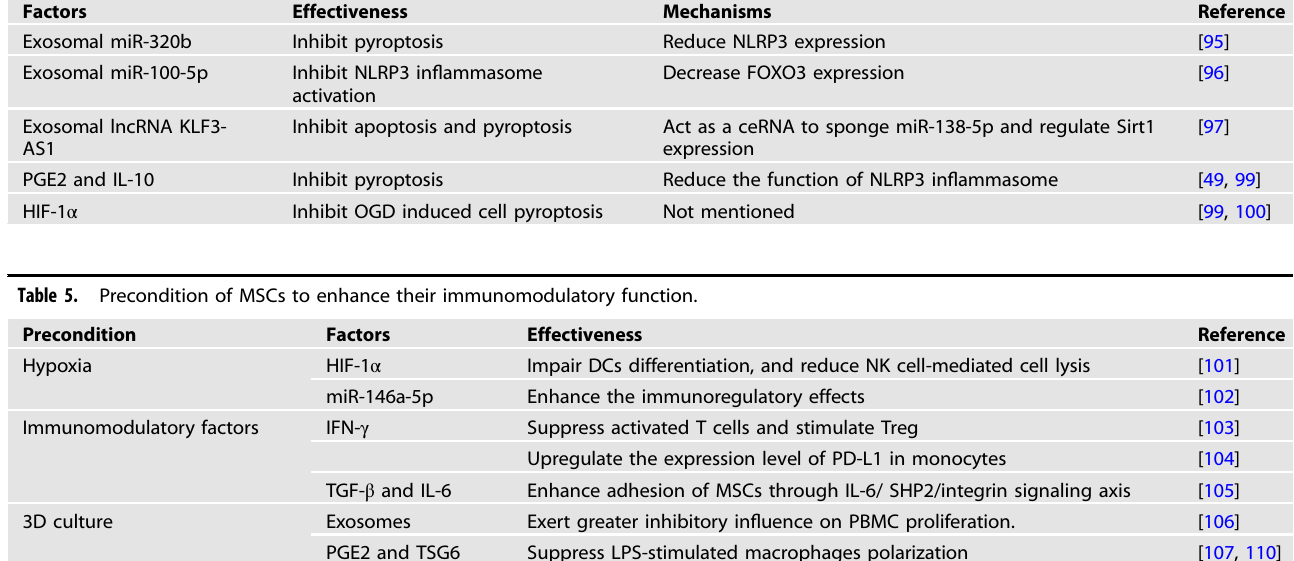
Table 4. Paracrine effectors of MSCs in regulation of